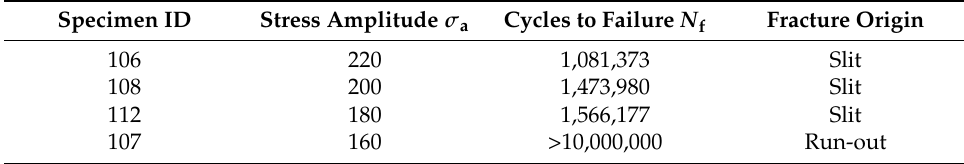
Table A6. Fatigue test results for